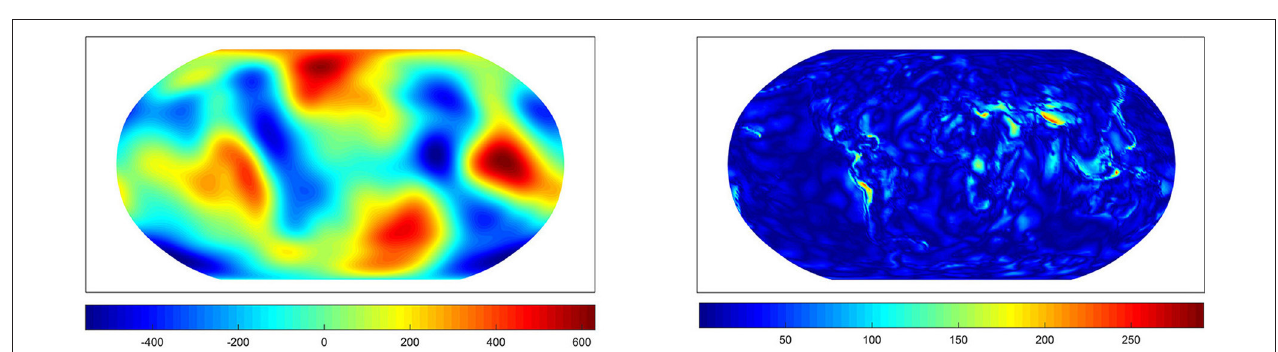
FIGURE 10 | The approximation from the RFMP for the best parameter (Left) and the difference to the EGM2008 up to degree 100 (Right) . Values in m 2 / s 2 .